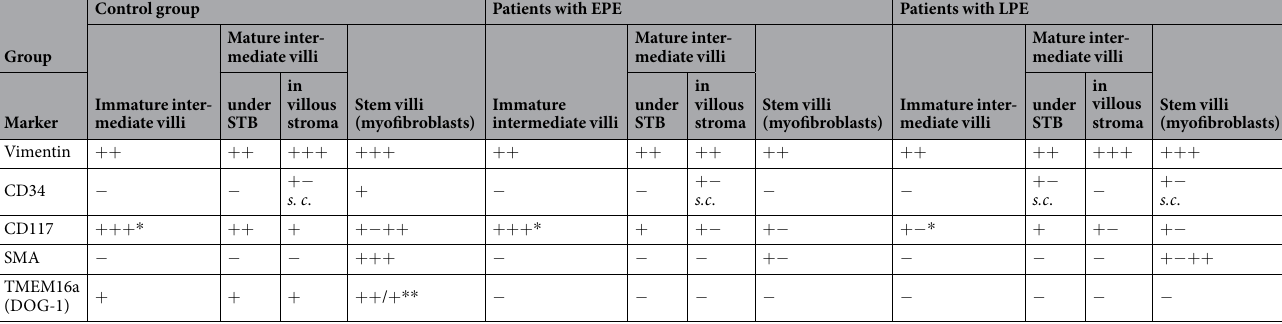
Table 2. Comparative immunohistochemical characteristics of telocytes from placental villi in patients in the preeclampsia and control groups. Comments. Note : * –marked staining both in the villi stroma and